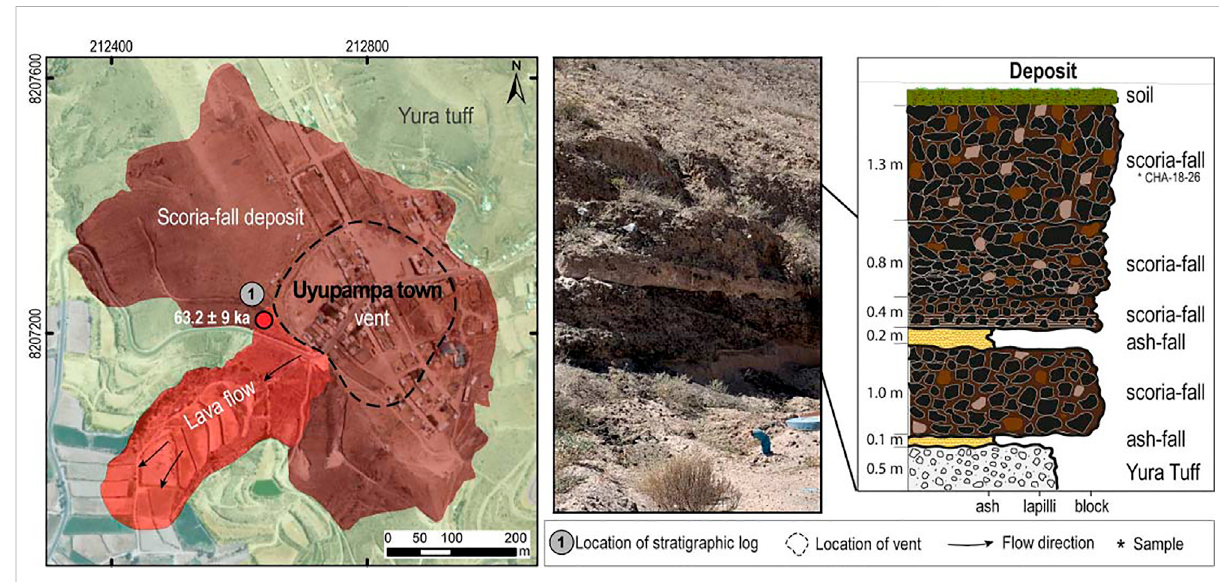
FIGURE 6 Geological map of Uyupampa volcano, showing a stratigraphic section and a picture of the outcrop where the section was